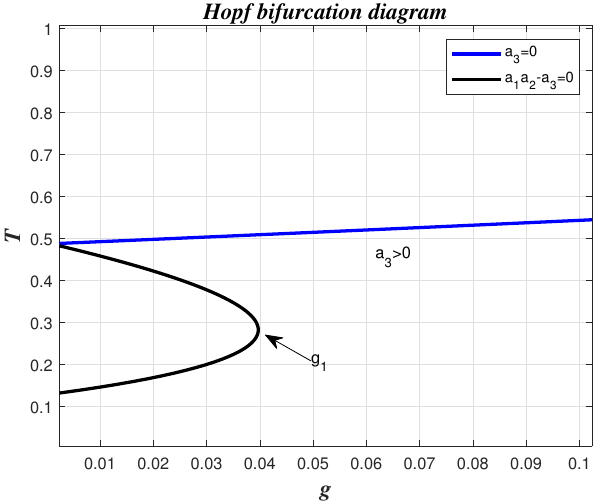
Figure 5. The conditions in (34) are illustrated. When g = g 1 , the model (1) has a coexistence equilibrium point E 3 = ( 0.8377,0.2983,1.2298 ) .